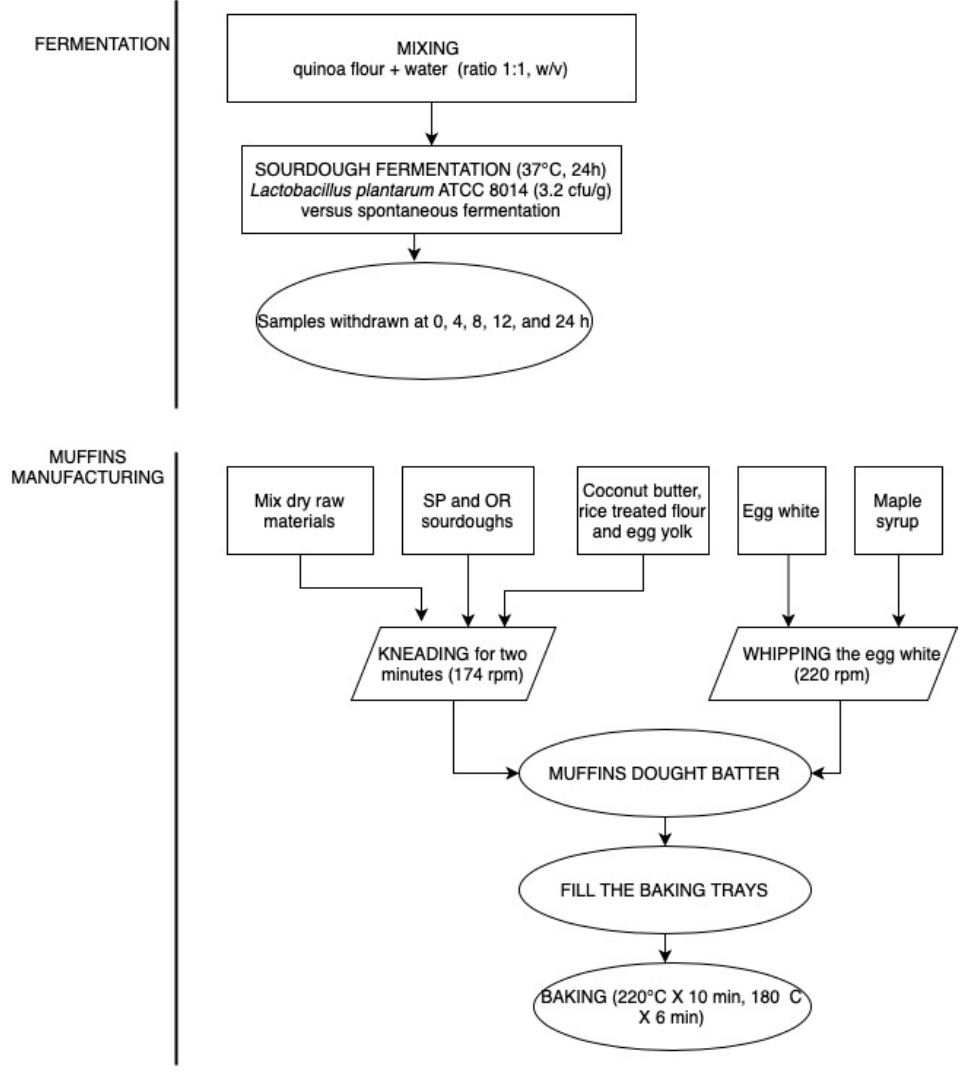
Figure 1. Flow diagram of sourdough (SP—sourdough fermented with Lactobacillus plantarum ; OR—spontaneous fermented sourdough) and muffins’ production.